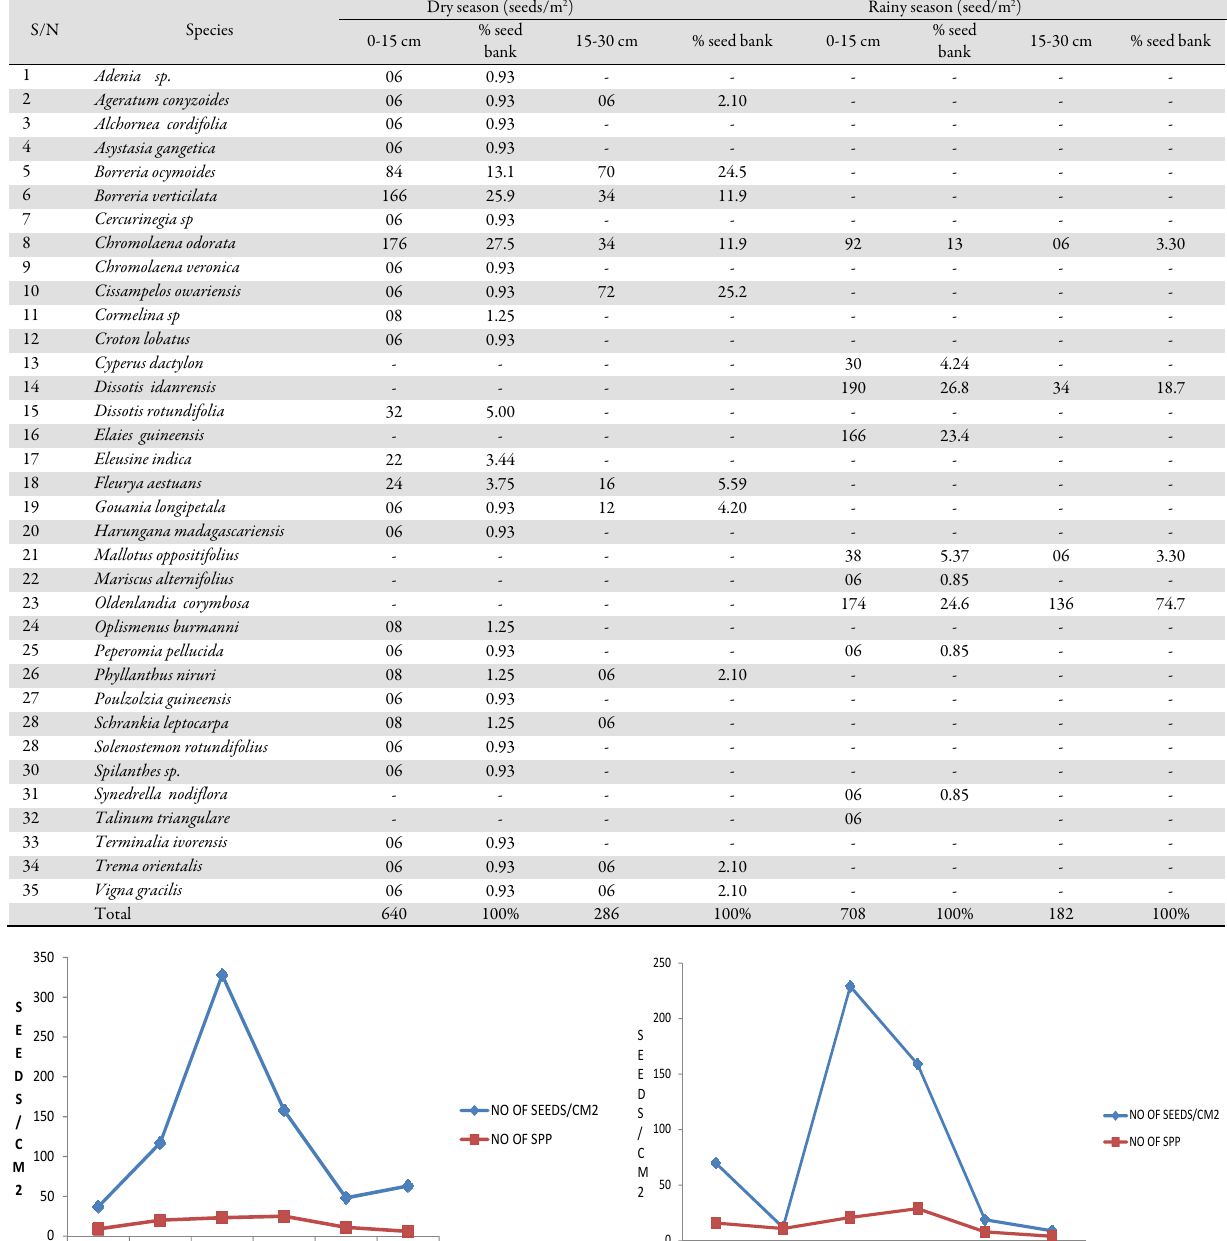
Table 3. Mean density (seeds/m 2 ) and percentage contribution of each species in the seed bank of riparian forest in both dry and rainy season at 0-15 cm and 15-30 cm S/N